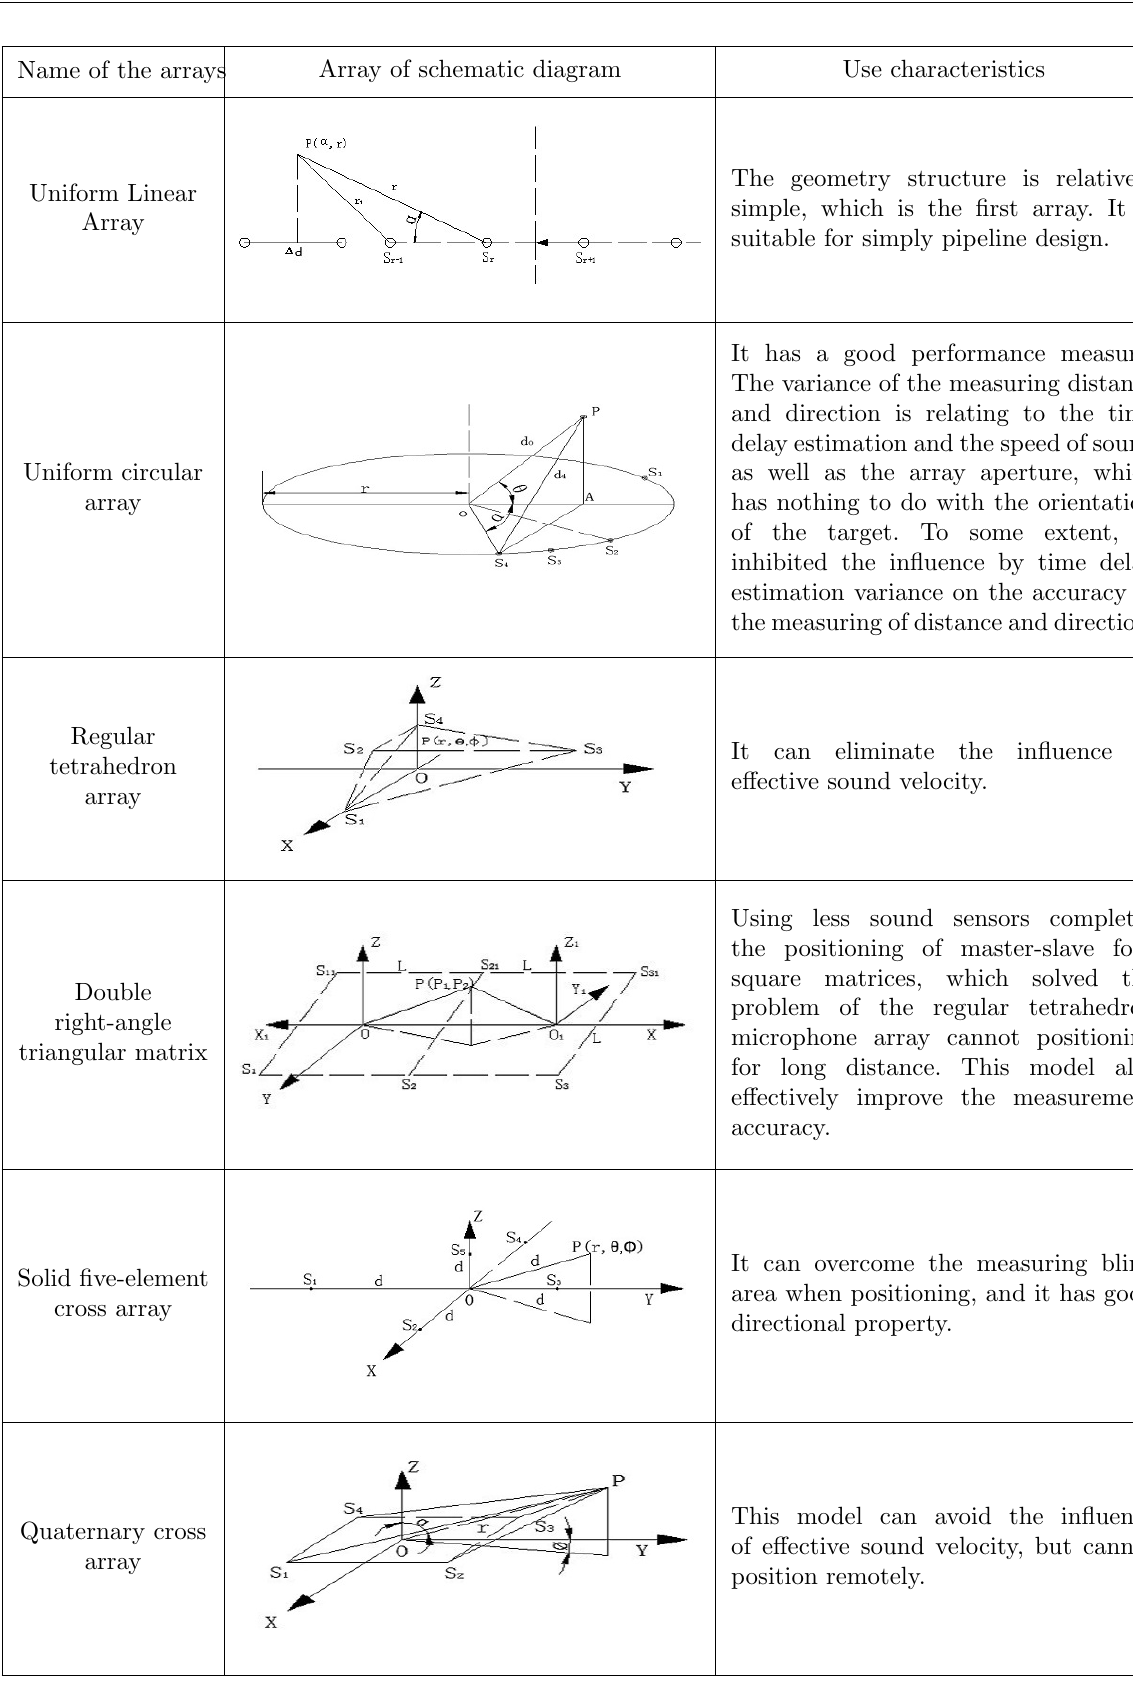
Table 6. Contrast table of sound sensor